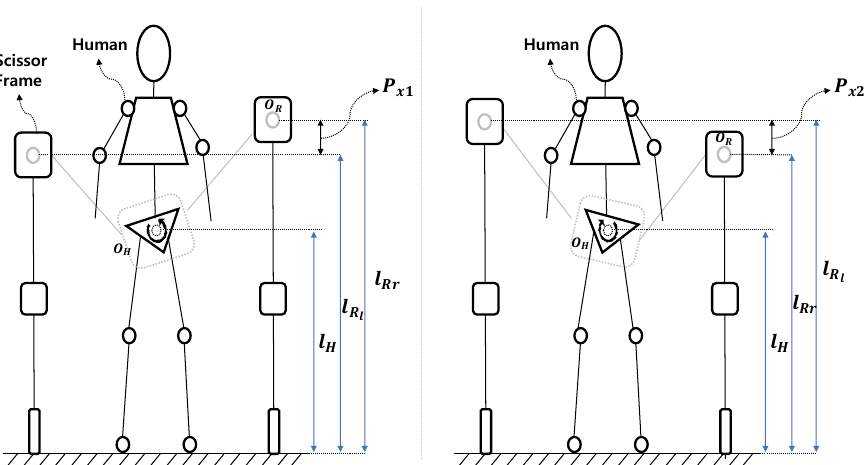
Figure 4. The appearance of using the scissor mechanism to generate the pelvic motion of paralytic patients. ( Left ) If right mechanism move upward and left mechanism move downward, system make counter clockwise pelvic obliquity motion. ( Right ) If left mechanism move upward and right mechanism move downward, system make clockwise pelvic obliquity